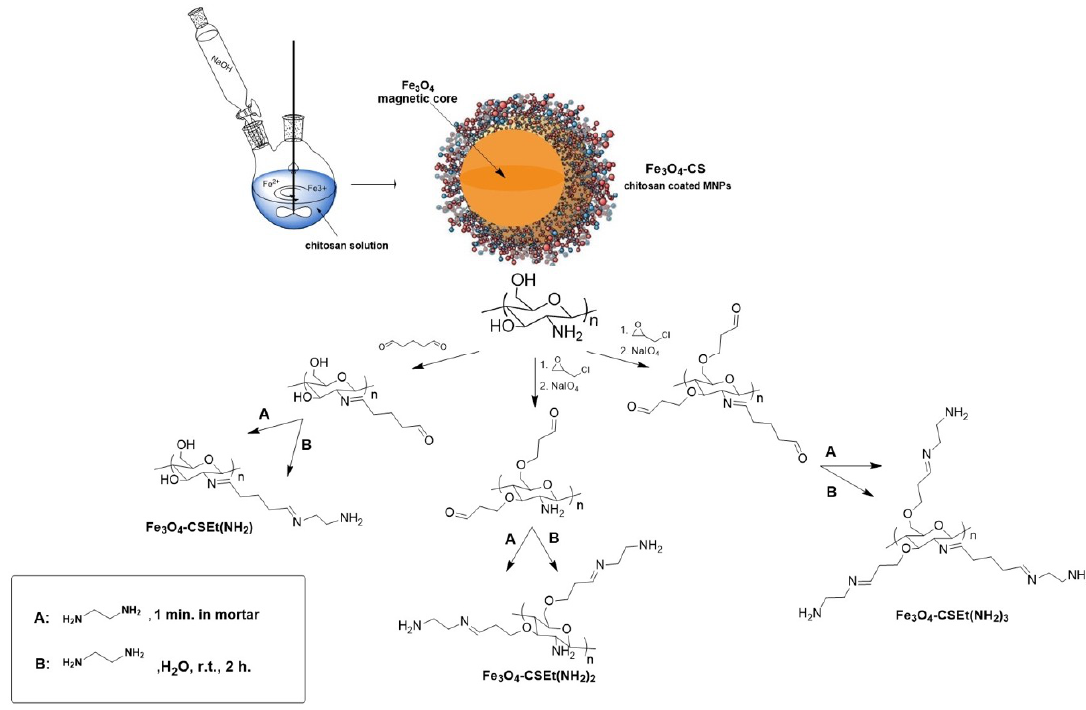
Figure 1. Scheme of the synthesis of aminated chitosan-coated nanoparticles Fe 3 O 4- CSEt(NH 2 ) 1–3.